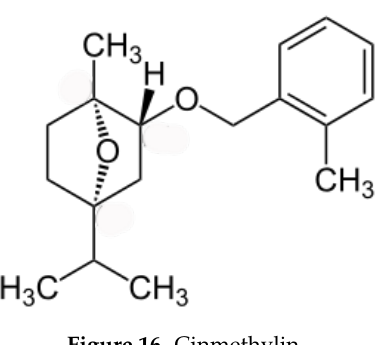
Figure 16. Cinmethylin.